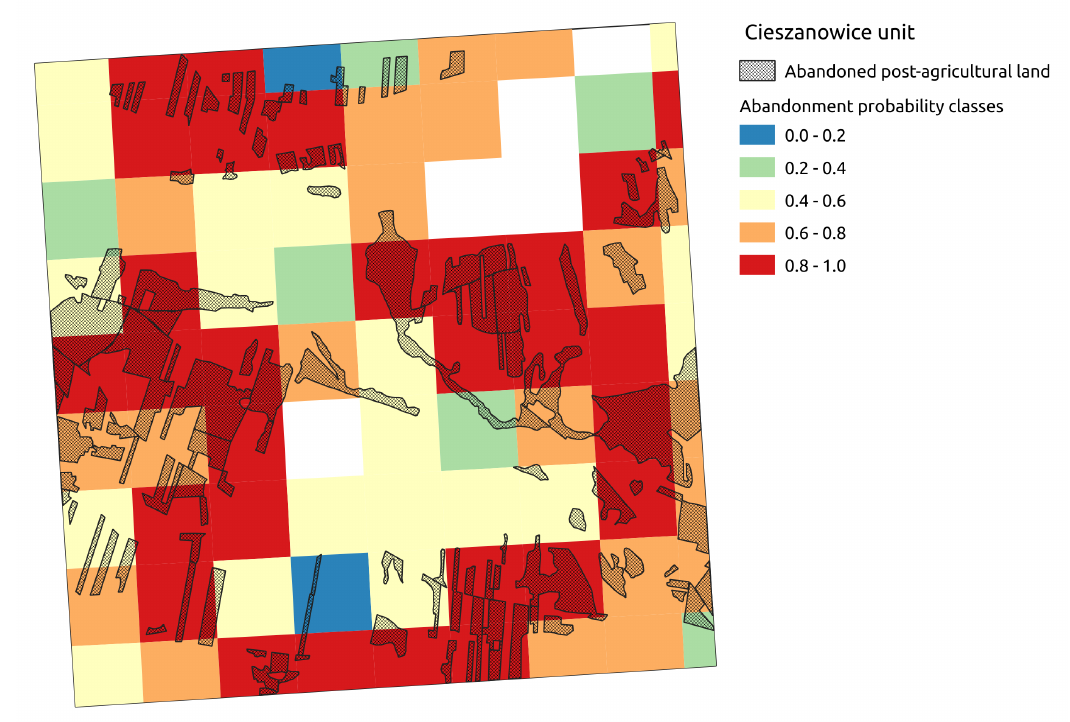
Figure 10. Abandoned postagricultural land in the “Cieszanowice” unit, superimposed over land abandonment probability classes (hotspot B).